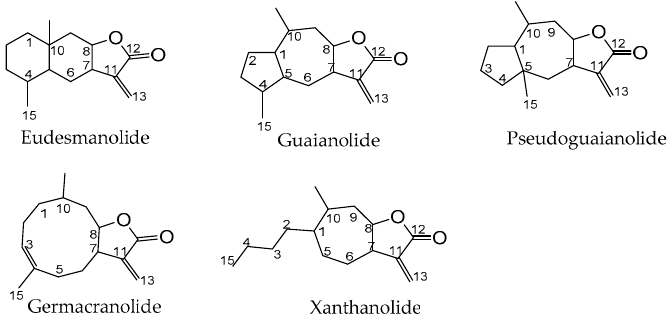
Figure 1. Basic chemical structure of each of the sesquiterpene lactone subclasses: eudesmanolide, guaianolide, pseudoguaianolide, germacranolide, and xanthanolide. Some of these subclasses have compounds that exhibit a wide range of biological activities.